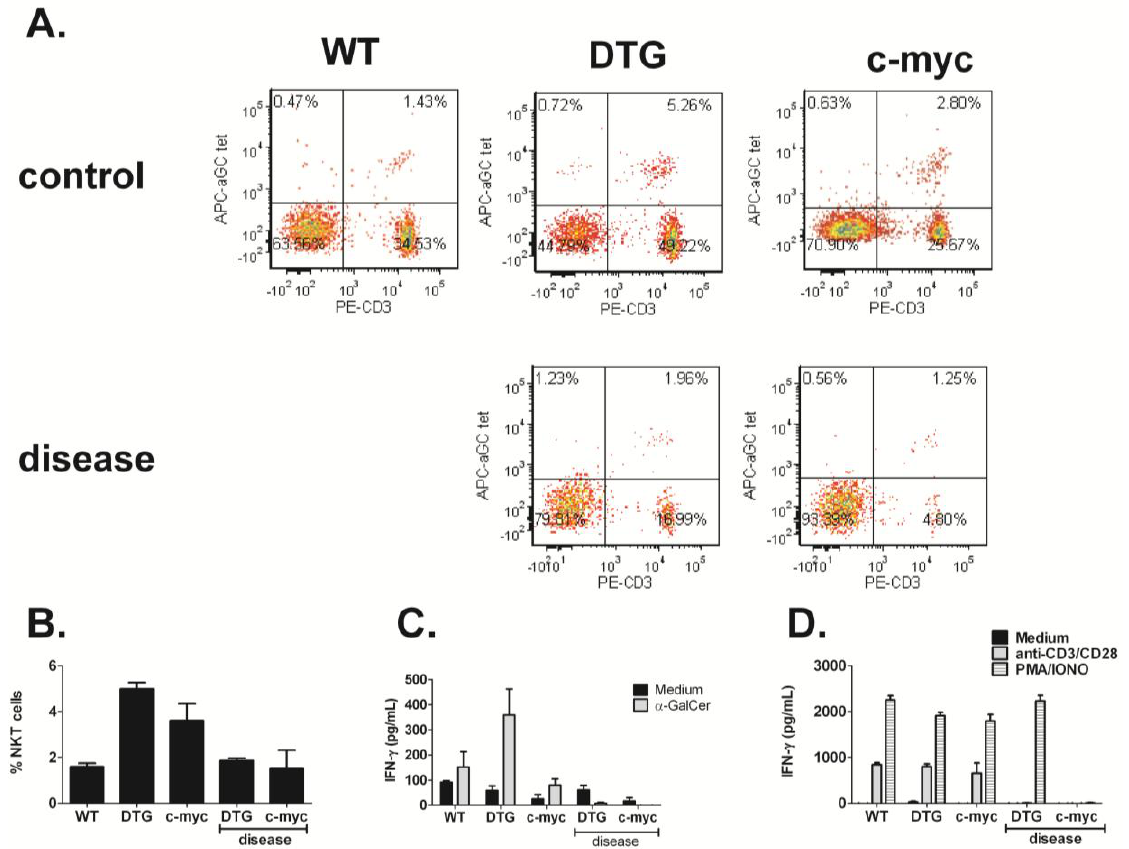
Figure 3. NKT cell responses are impaired during lymphoma progression. ( A ) Splenic